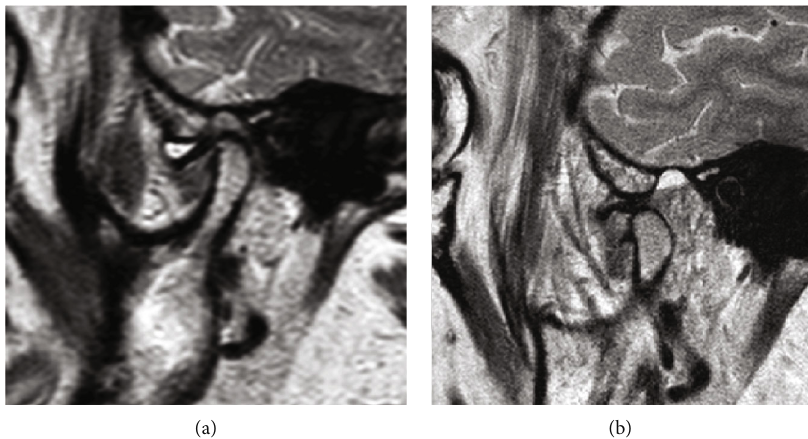
Figure 2: Initial MRI of the left TMJ with the patient ’ s mouth closed (a) and open